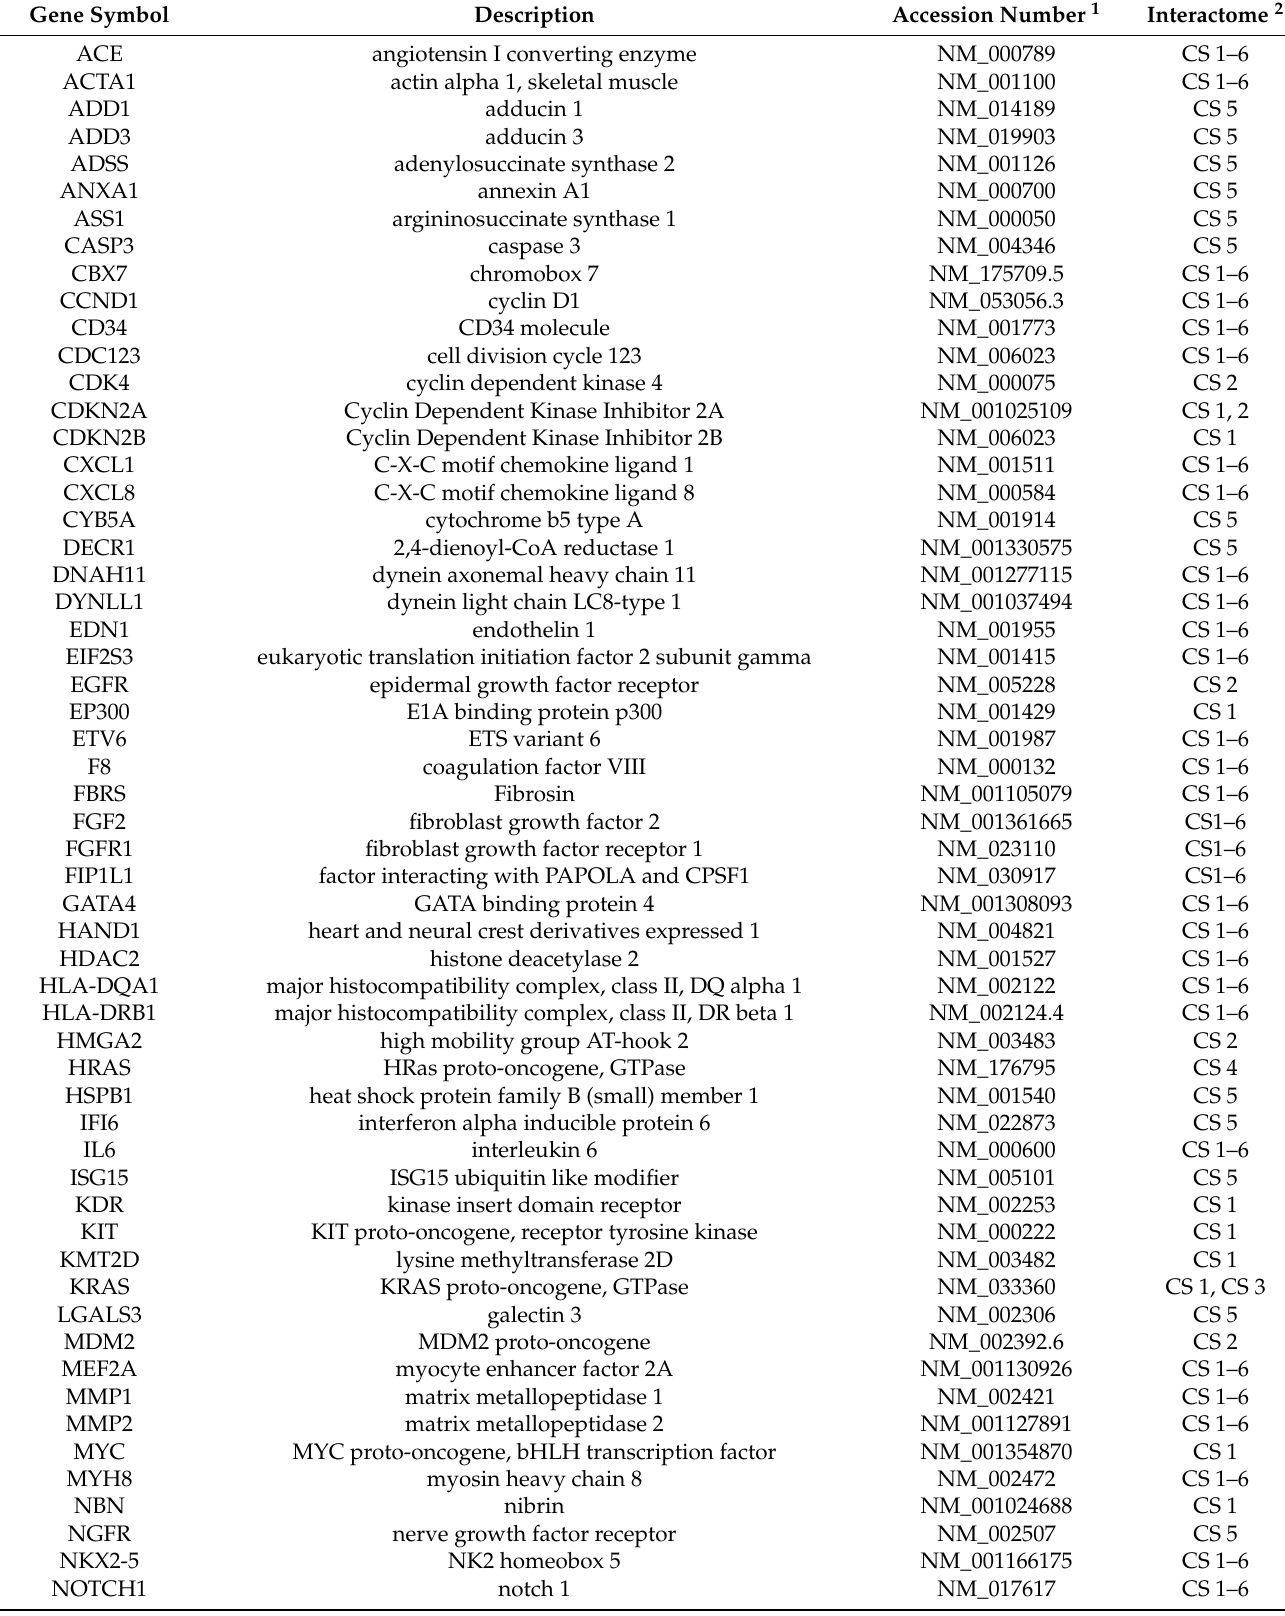
Table 1. Molecules included in the primary heart sarcomas interactions networks CS